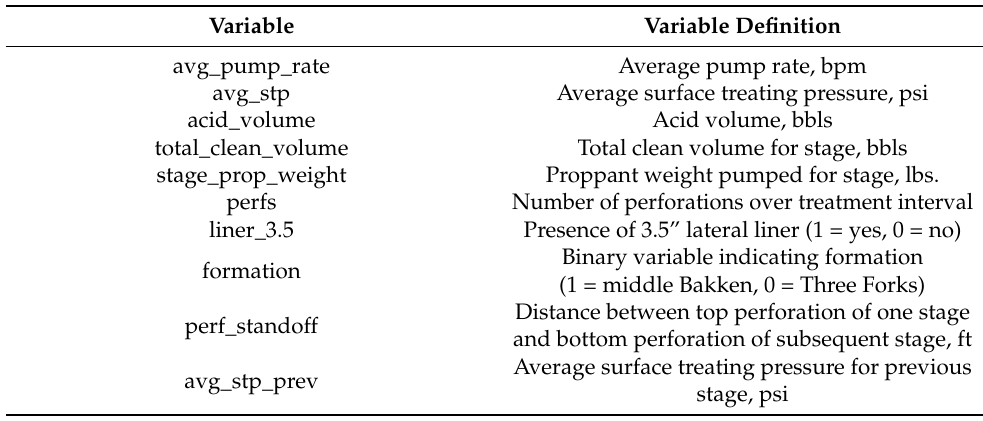
Table 2. Variable definitions for data set used in this